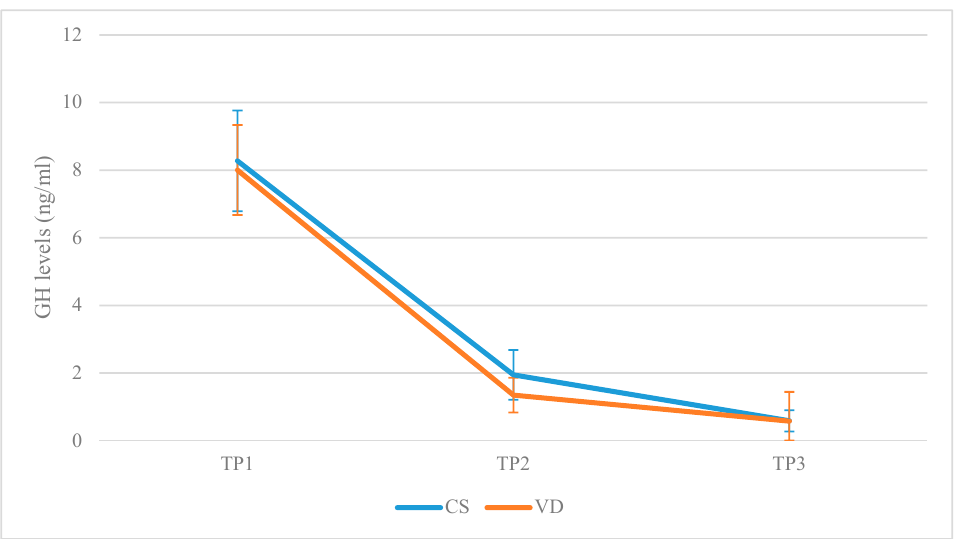
Figure 4. Growth hormone (GH) levels reported in the CSG and in the VDG, respectively, on each of the three separate time-points (TP1: Prior to labor; TP2: 120 min following placenta delivery; TP3: 48 h following placenta delivery).